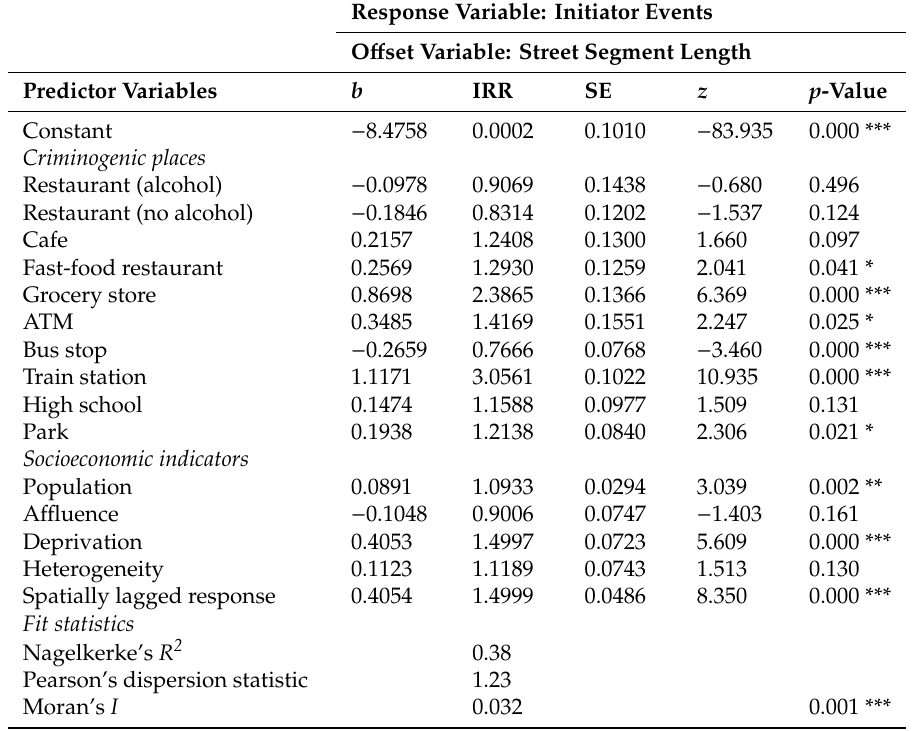
Table 2. Results from negative binomial regression based on 1569 significant initiator events of street robberies in Malmö in